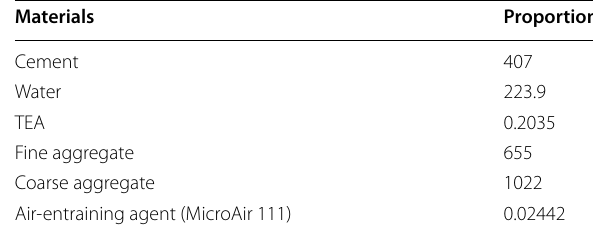
Table 1 Mix proportioning of concrete (kg/m 3